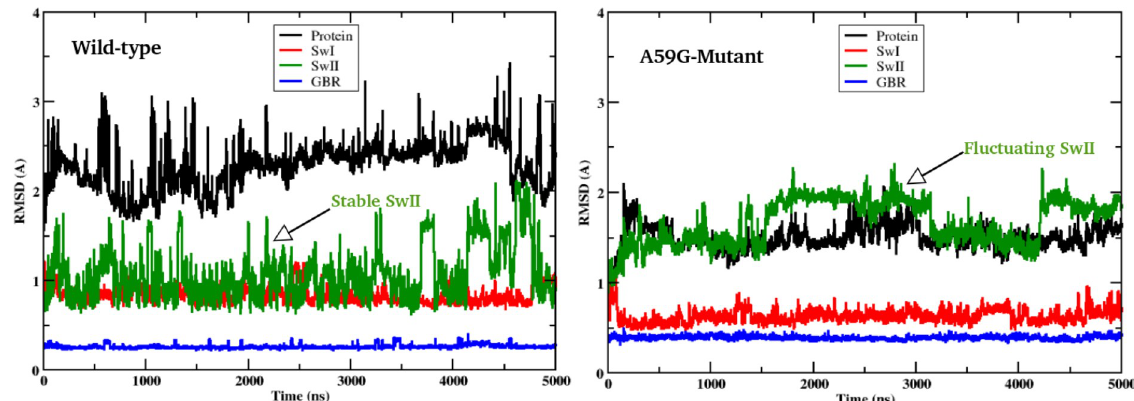
https://doi.org/10.1371/journal.pone.0234836.g001